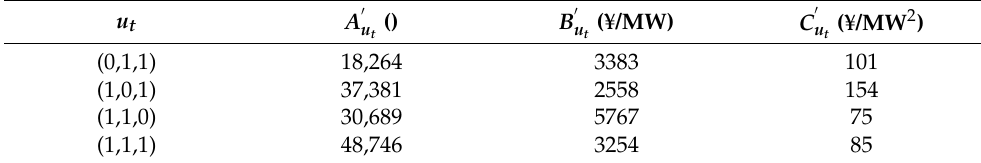
Table 2. Calculated coefficients in Figure 3 (“¥” means “any currency unit is